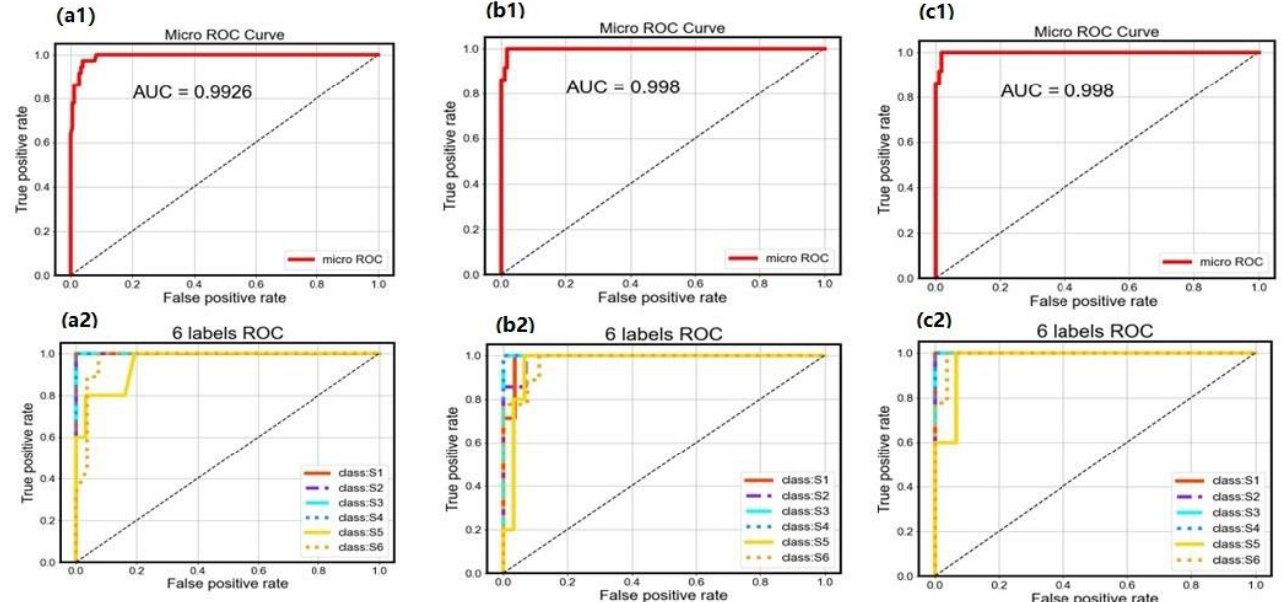
Figure 7. The evaluation of RF classification based on different datasets: ( a1 ) AUC based on the original data, ( b1 ) AUC based on the PCA data, and ( c1 ) AUC based on the TNSE data; ( a2 ) ROC curve based on the original data, ( b2 ) ROC curve based on the PCA data, and ( c2 ) ROC curve based on the TNSE data. Class S1 refers to LRW, class S2 refers to LE, class S3 refers to ICRE, class S4 refers to AeroE, class S5 refers to ANE, and class S6 refers to MBRE.